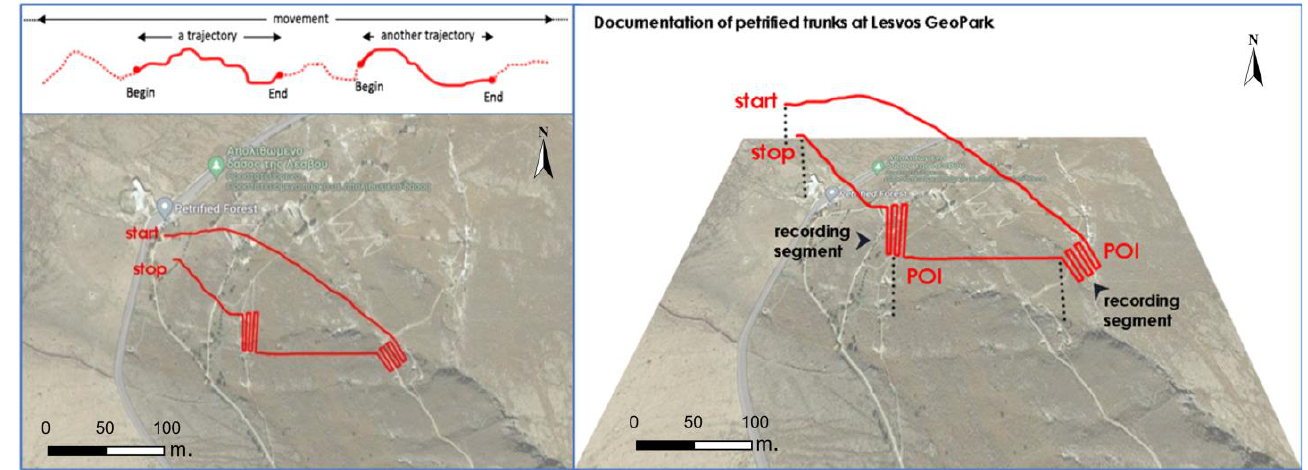
Figure 1. Example semantic trajectory depicting a documentation behavior on the Geopark, starting from a simple trajectory, and resulting in a semantic trajectory.